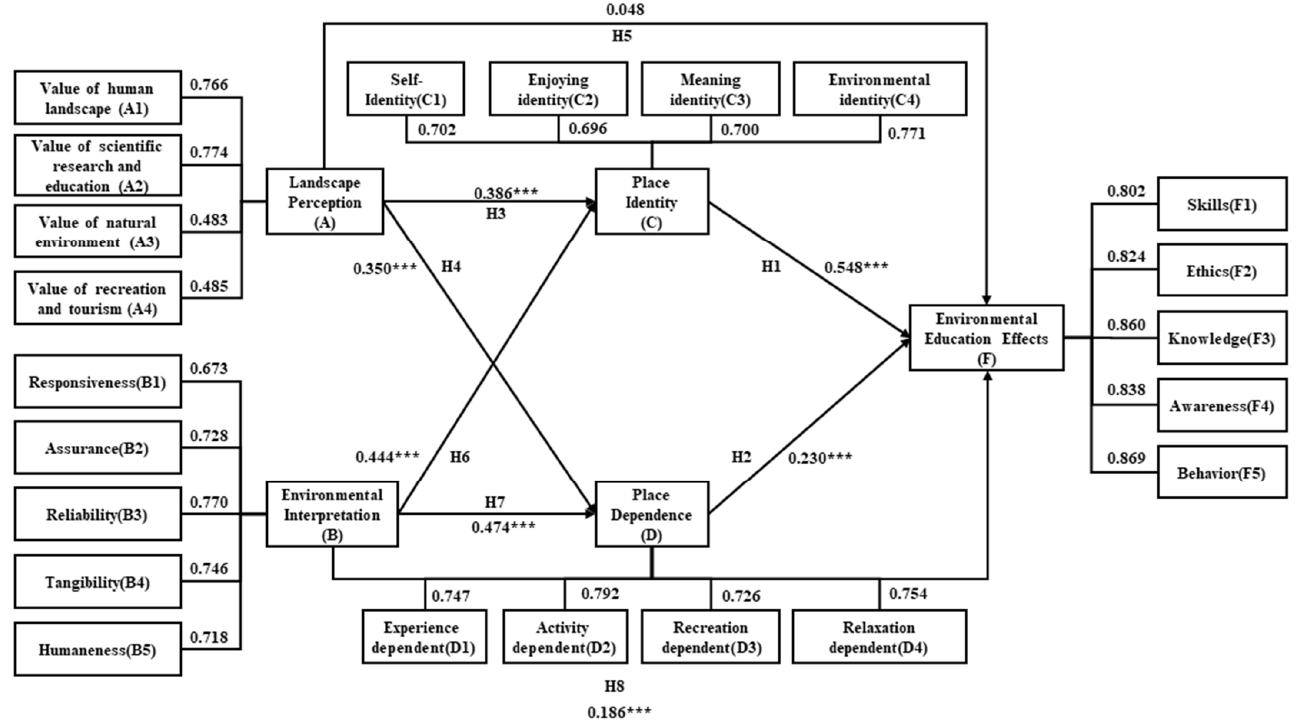
Figure 2. Structural equation model test analysis diagram ( p < 0.001, ***). Table 3. Path Testing ( p < 0.001, ***).